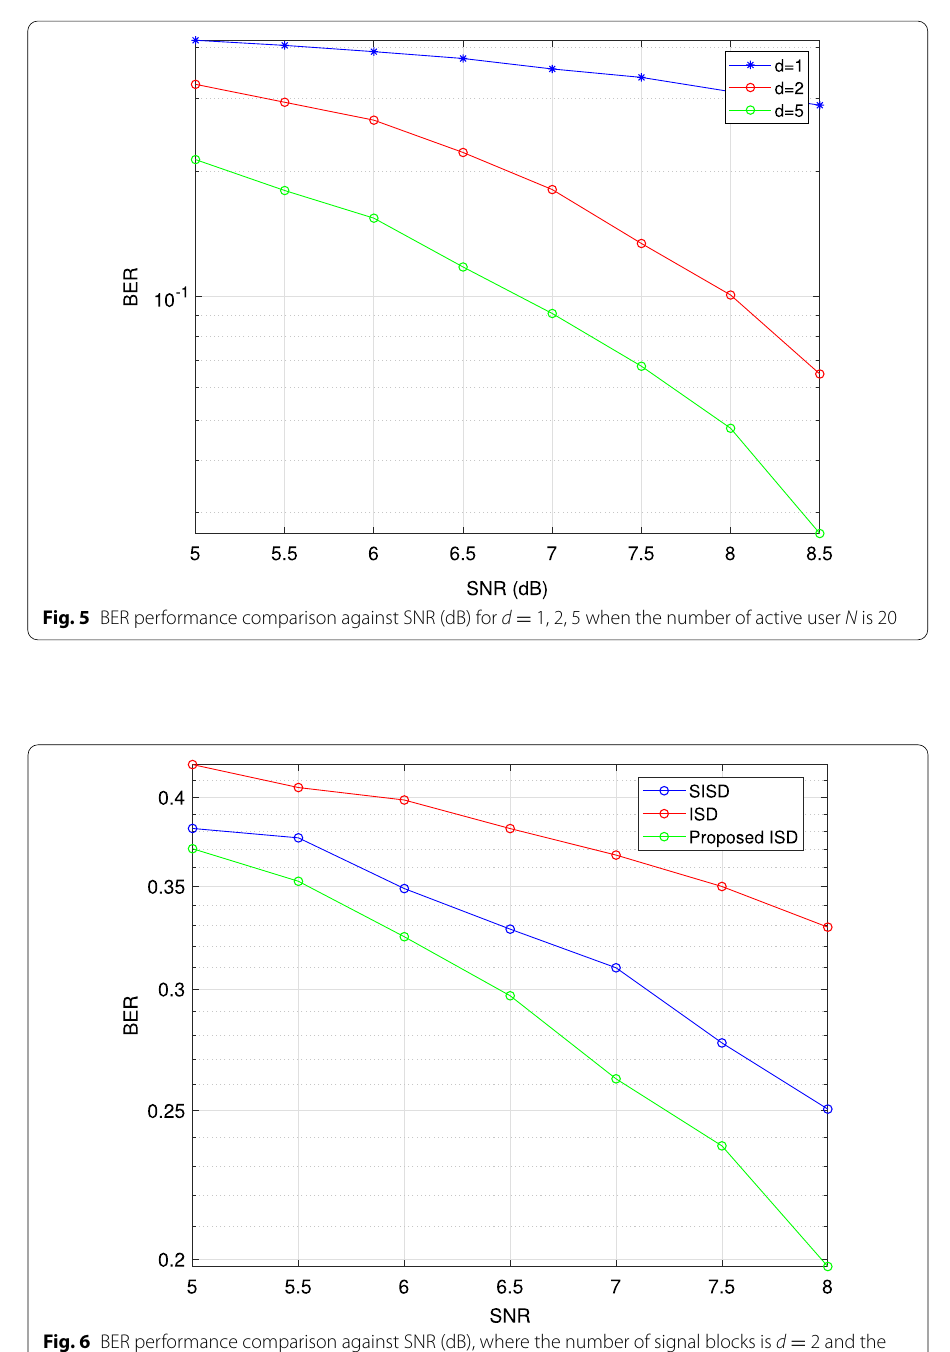
2 when the number of active user N is 20 =